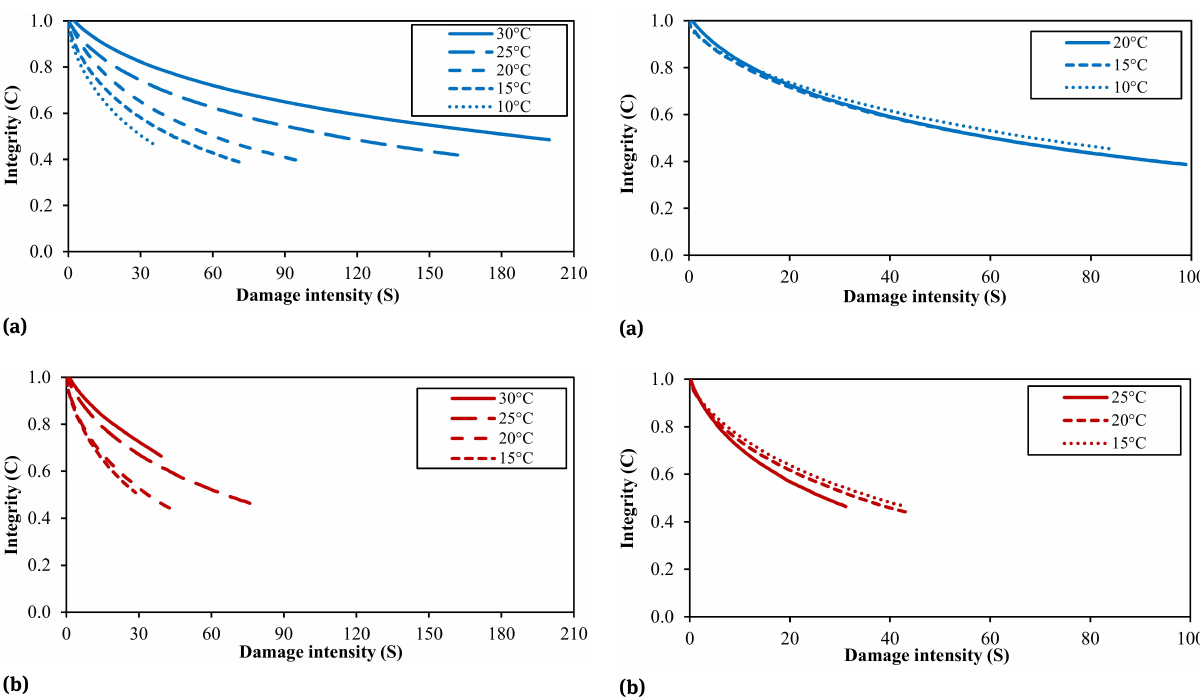
Figure 6: Damage characteristic curves: (a) HPMB and (b) AC 30/45 Figure 7: Shifted damage characteristic curves: (a) HPMB and (b) AC